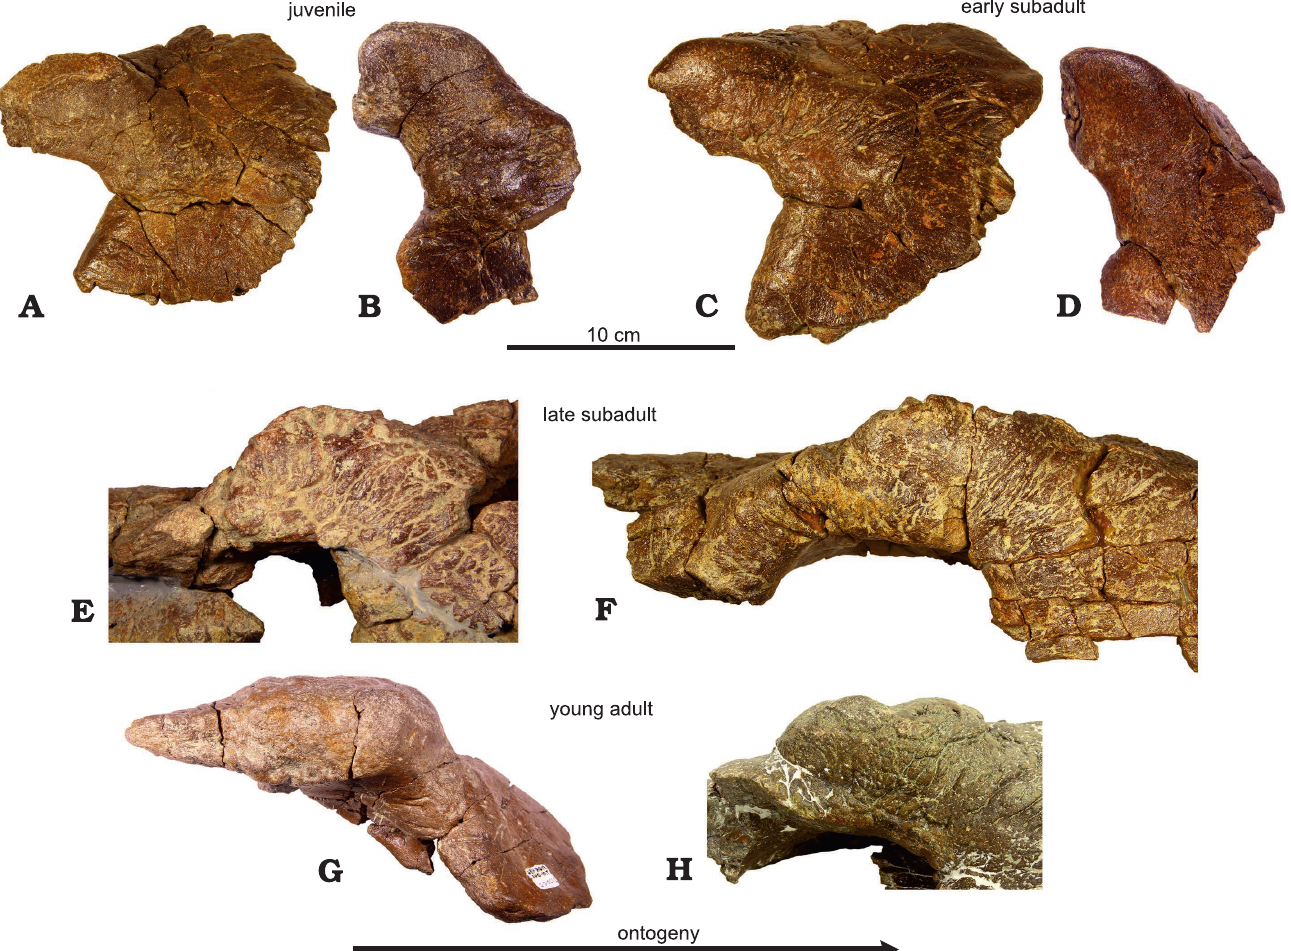
Fig. 7. Ontogenetic series of supraorbital ornamentation of Einiosaurus procurvicornis Sampson, 1995 from the Campanian Canyon Bonebed (TM-046), Montana, USA. A , B . Juve nile, MOR 456 8-10-87-20 ( A ) and MOR 456 8-8-87-19 ( B ). C , D . Early subadult, MOR 456 8-9-7-3 ( C ) and MOR 456 2020- C-1 ( D ). E , F . Late subadult, MOR 456 8-8-87-1 ( E ) and MOR 456 8-23-87 ( F ). G , H . Young adult, MOR 456 2020-C-2 ( G ) and MOR 456 8-9-6-1 ( H ). B, D–G are mirrored. All specimens in lateral view, anterior is to the left in all